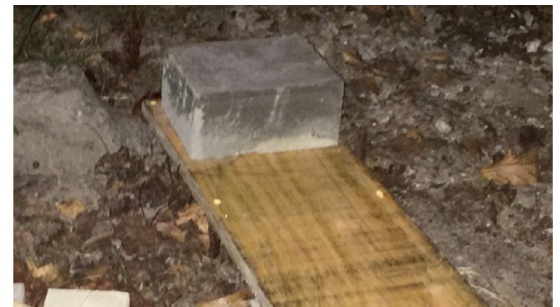
Fig. 11: The forms were removed, leaving four equal sized concrete blocks After the blocks were free from the form, all fibers were trimmed to be flush with the sides of the blocks. Fig. 12 and 13 depict the blocks after they were removed from the forms.